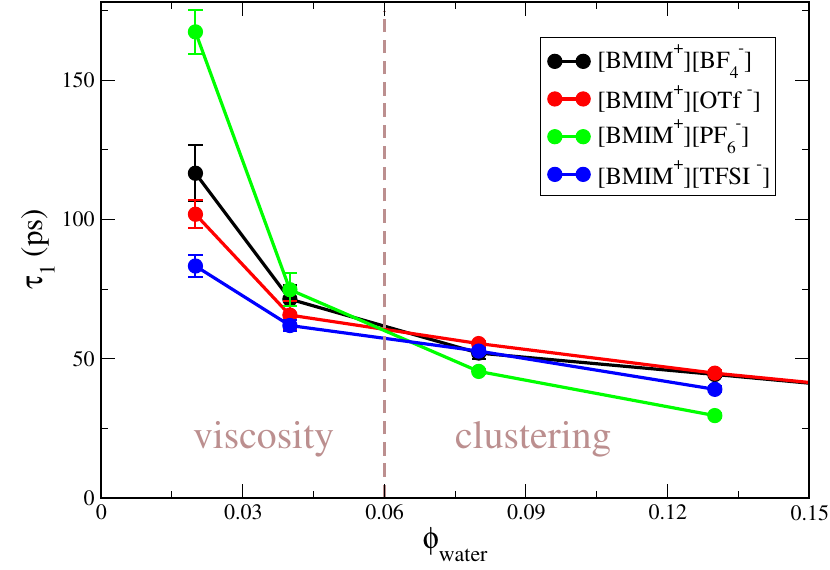
Figure 1. Rotational correlation time τ 1 of water molecules as a function of water volume fraction φ water for [BMIM + ][BF − ], [BMIM + ][OTf − ], [BMIM + ][PF − ] and [BMIM + ][TFSI − ]IL/water mixtures. 6 4 The vertical dashed line qualitatively indicates the separation of “viscosity” and “clustering” dictated water dynamics. Error bars are given as the difference between predictions separately computed by dividing the trajectory in